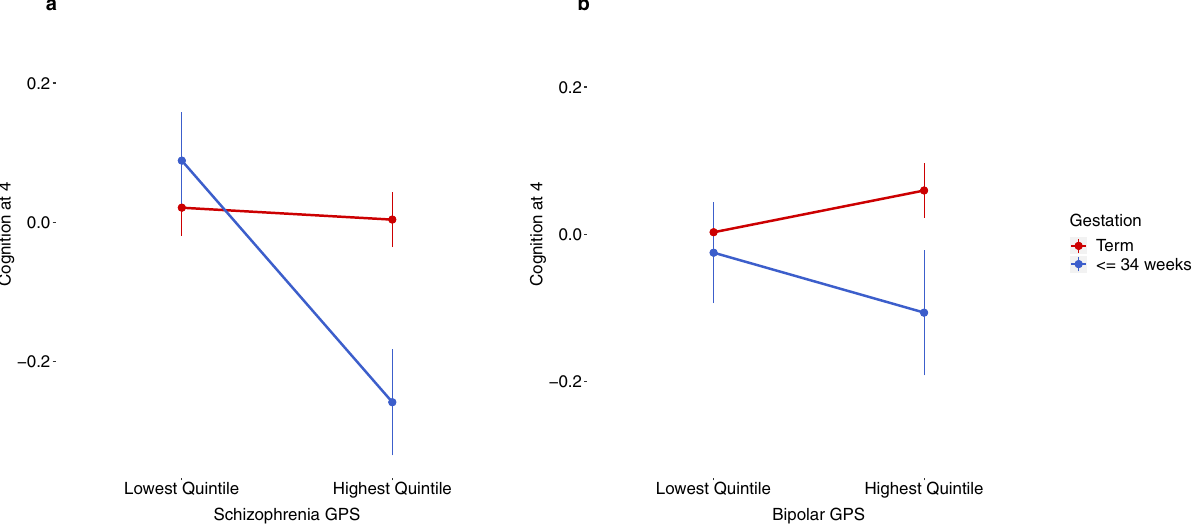
Figure 1. ( a ) Mean cognitive score at age four corrected for sex and SES by Schizophrenia GPS and gestational age for individuals falling in the highest and lowest 20% of the distribution of Schizophrenia GPS. There was evidence for an interaction effect (F(1506) = 8.03, p = 4.65 × 10 –3 ); ( b ) Mean cognitive score at age 4 corrected for sex and SES by Bipolar disorder GPS and gestational age for individuals falling in the highest and lowest 20% of the distribution of the Bipolar Disorder GPS. No statistically significant interaction effect was found (F(1530) = 1.55 P = 0.213), GPS : genome-wide polygenic